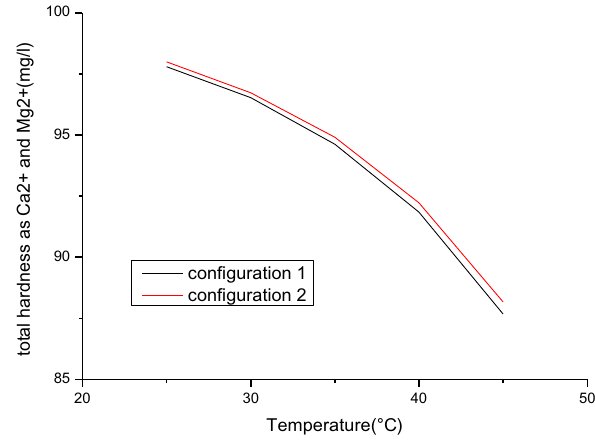
Fig.14 Comparison between conf a and conf b on recovery ratio at